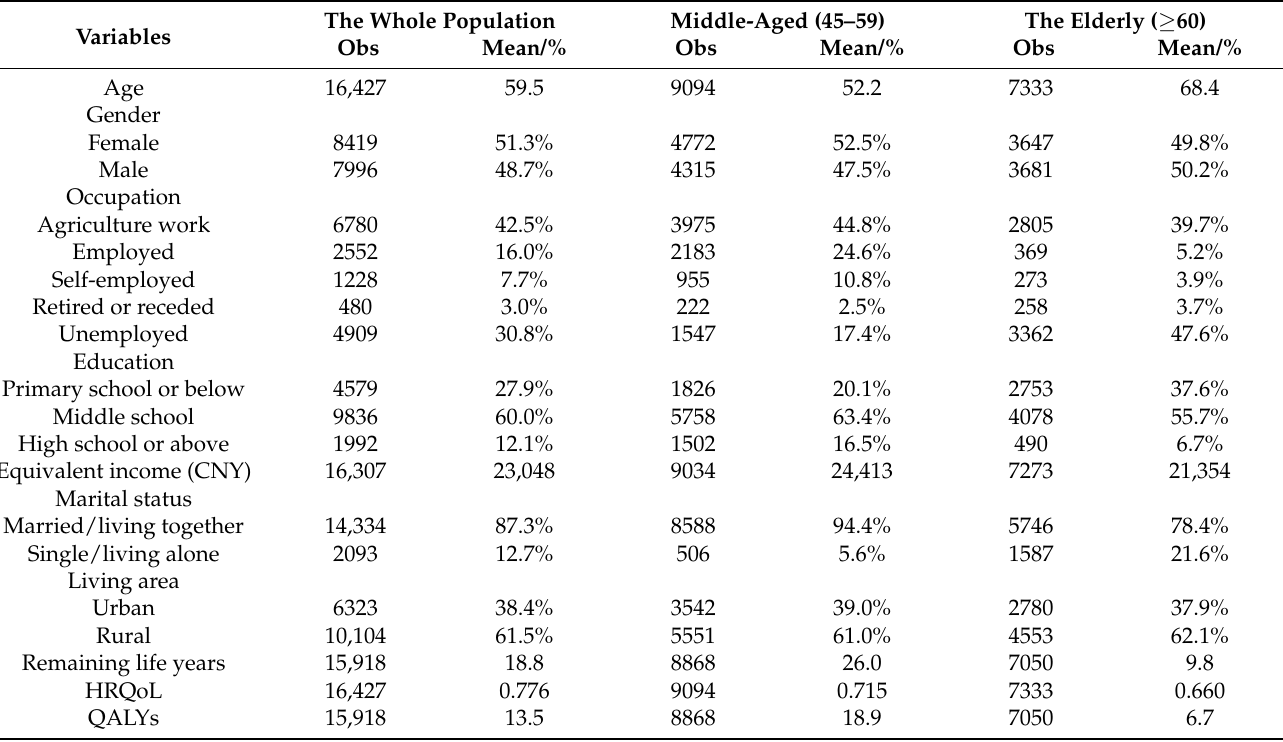
Table 1. Descriptive statistics in